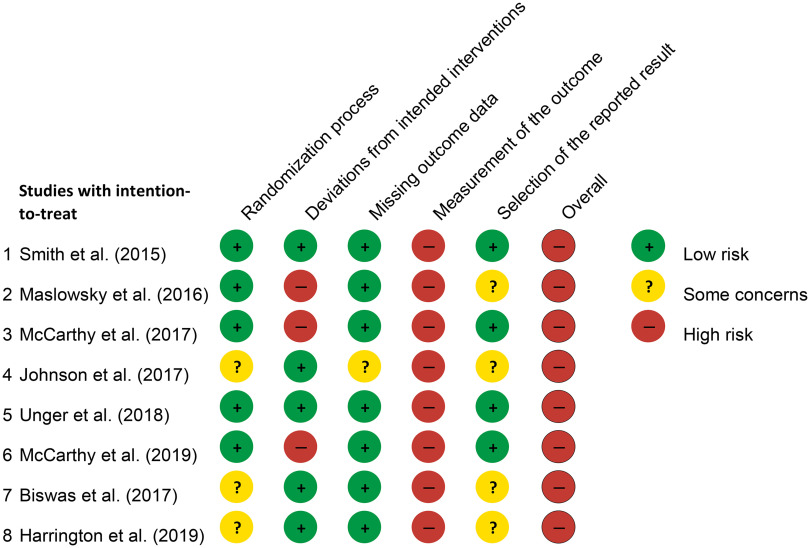
Risk of Bias in Studies of mHealth Interventions to Increase Contraceptive Uptake in Low- and Middle-Income Countries, N=8